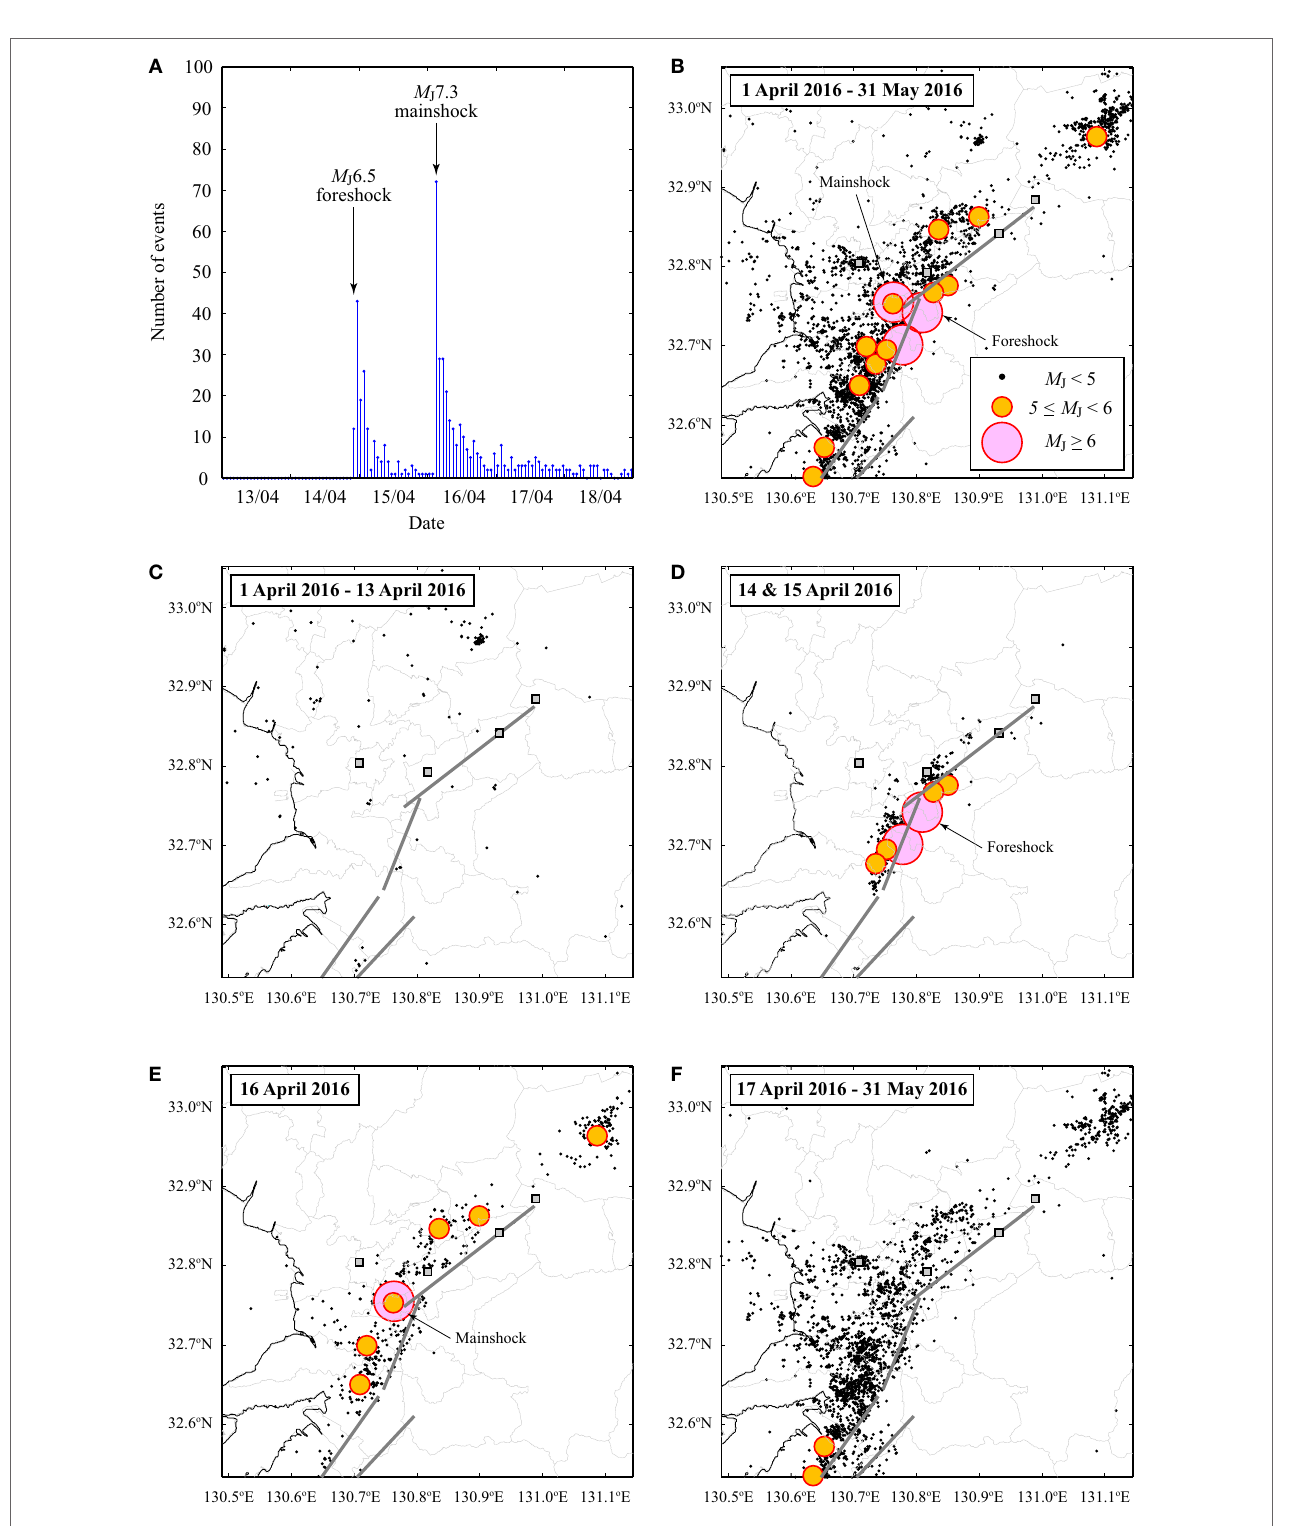
FigUre 2 | (a) Number of earthquakes with M J > 3 that occurred in the Kumamoto region during April 1, 2016 to May 31, 2016. Spatial distribution of earthquakes in the Kumamoto region: (B) April 1, 2016 to May 31, 2016, (c) April 1, 2016 to April 13, 2016, (D) April 14 and 15, 2016, (e) April 16, 2016, and (F) April 17, 2016 to May 31, 2016.